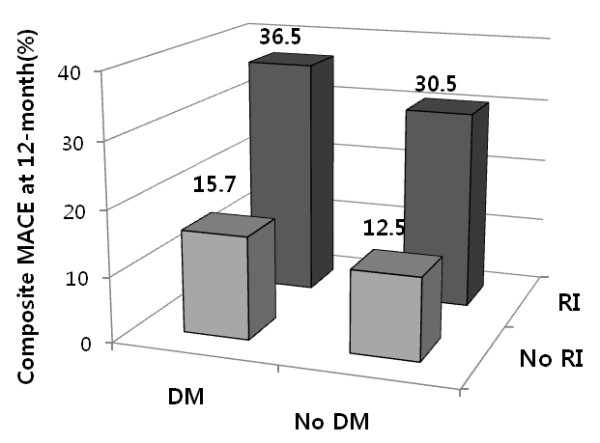
Composite MACE at 12-month stratified by the presence diabetes mellitus (DM) and renal insufficiency (RI).